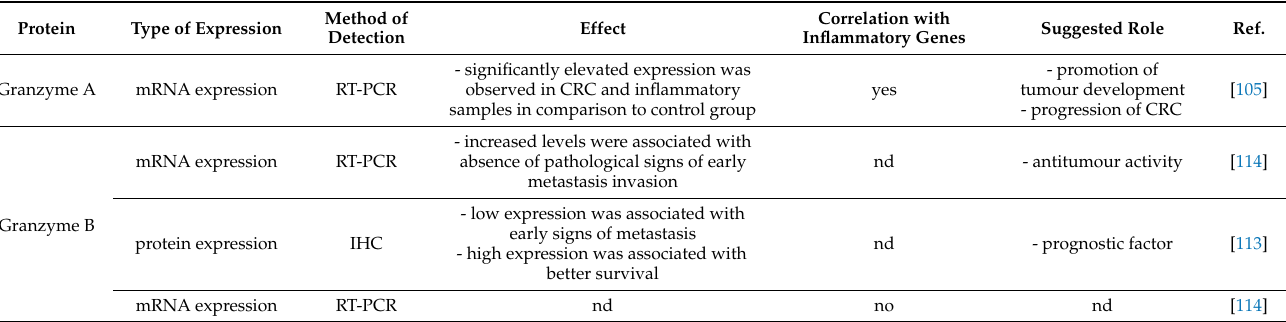
Table 2. The role of selected GZMs in